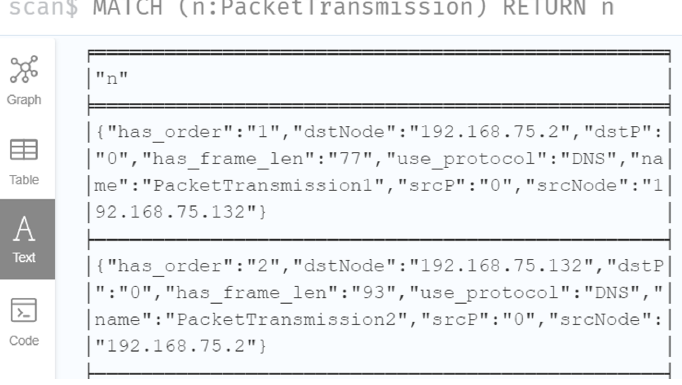
Figure 9. The attributes of packet